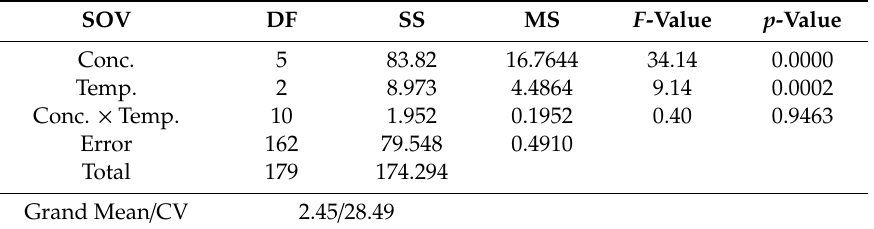
Table A11. Fecundity of M. persicae in relation to PeBL1 elicitor and temperature (ANOVA).